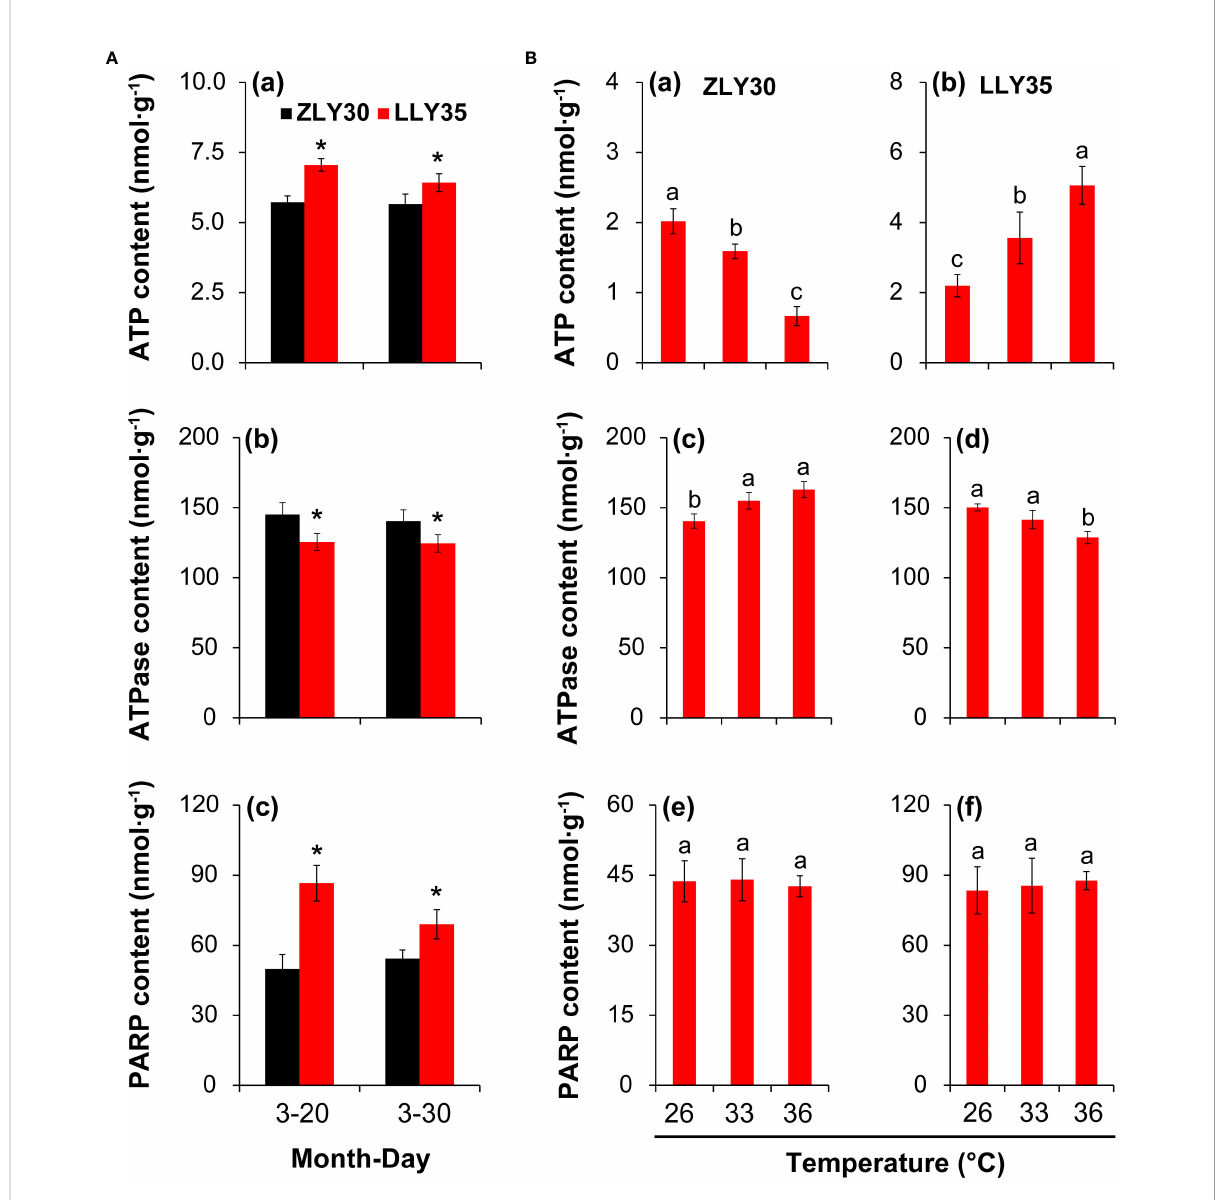
FIGURE 5 Effect of different sowing times and temperatures on energy metabolism in grains of rice. (A) , Content of ATP (a) , ATPase (b) , and PARP (c) in ZLY30 and LLY35 at different sowing times; (B) , Content of ATP (a, b) , ATPase (c and d), and PARP (e and f) of two cultivars under different temperatures; Vertical bars denote standard deviations ( n =3). “ * ” indicated signi fi cant difference while “ No.s ” indicate no signi fi cant difference at the 0.05 probability level between the ZLY30 and LLY35 within one sowing time using T-test analysis. Different letters indicate signi fi cant differences with a least signi fi cant difference test at P ≤ 0.05 among different temperatures within one genotype using one-way analysis of